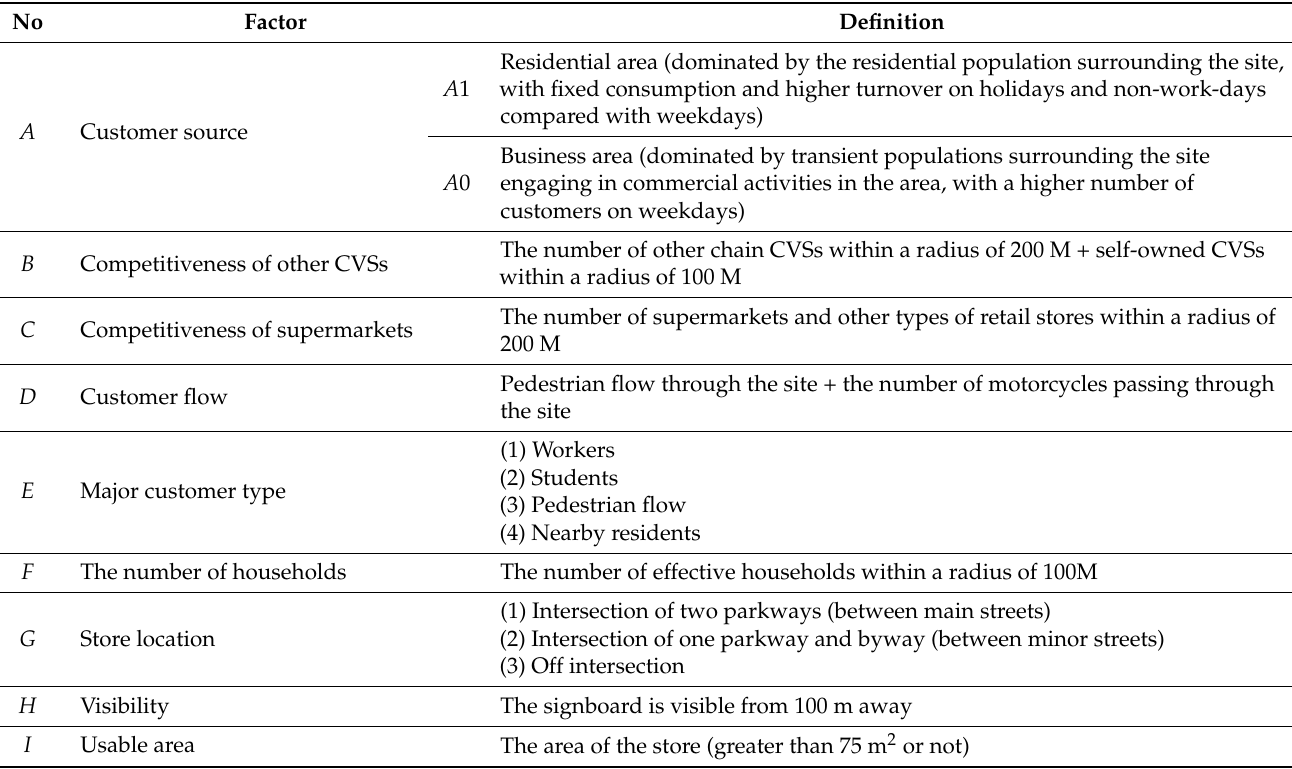
Table 1. Definitions of site selection assessment